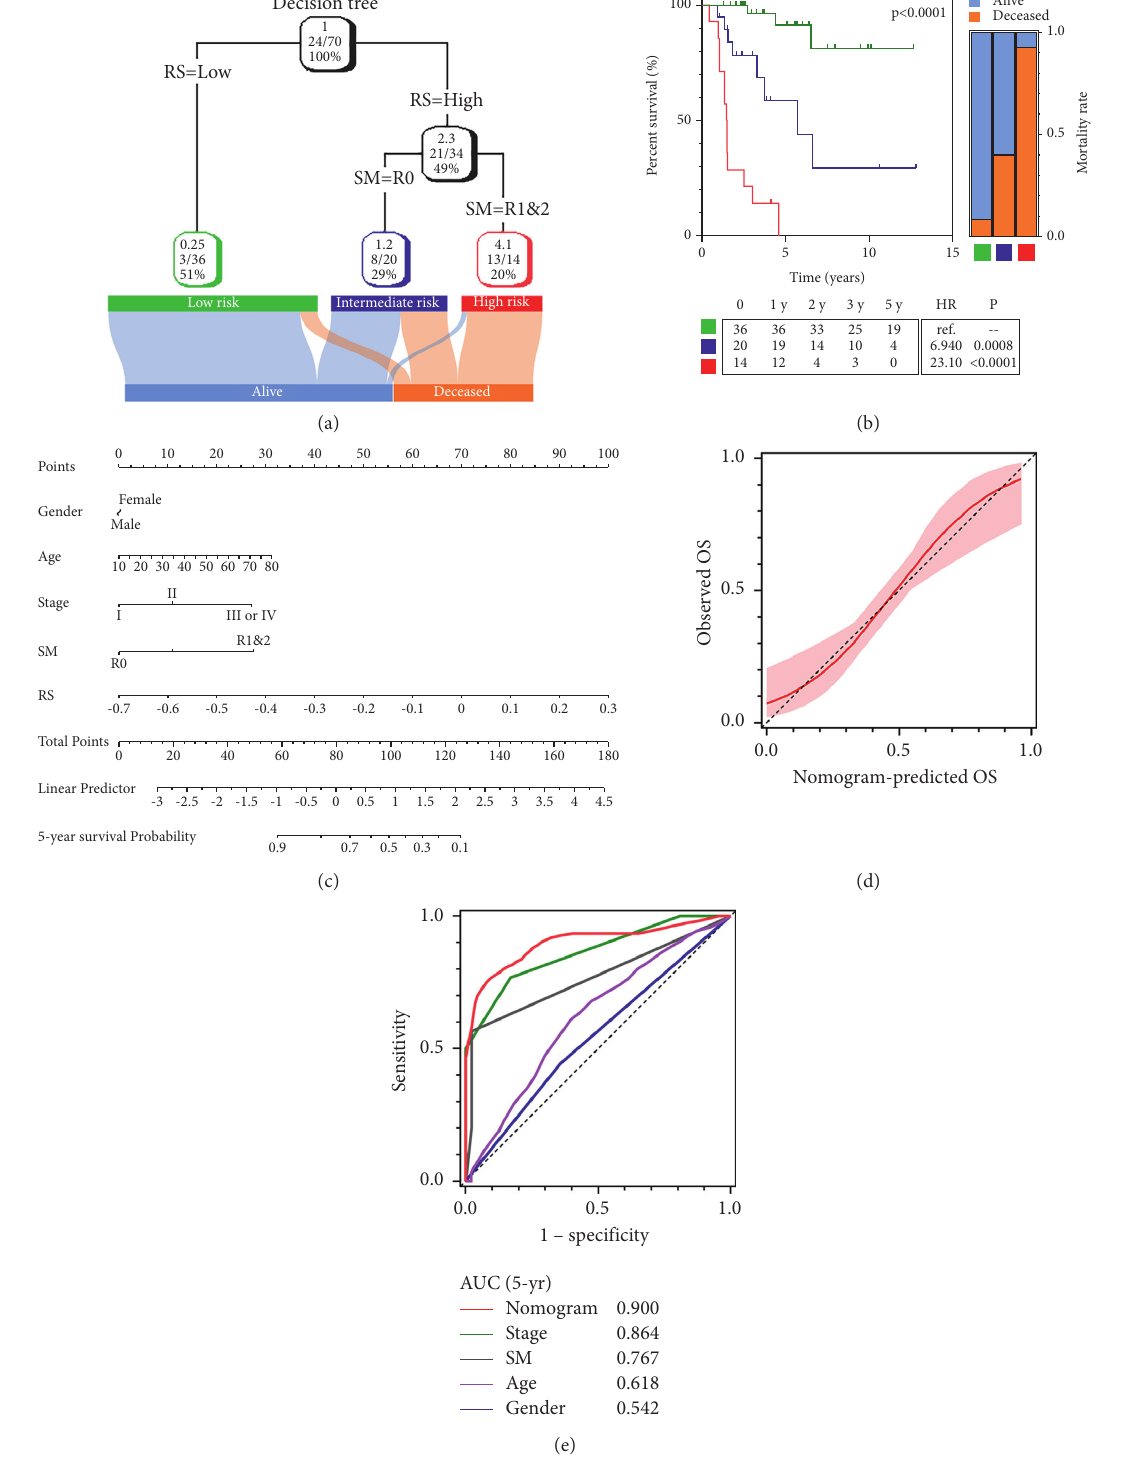
Figure 4: Construction of an integrated model to optimize risk stratification and personalize risk assessment: (a) a decision tree was generated based on the TCGA cohort, with a risk score and SM status incorporated as two major components; (b) overall survival differed significantly in different risk subgroups, and mortality increased gradually as risk level increased; (c) a nomogram was constructed to personalize risk assessment for individual patients; (d) the calibration curve showed the nomogram-predicted survival to be close to ideal performance; and (e) tROC analysis of all clinicopathological parameters demonstrated the greatest accuracy of the nomogram for survival